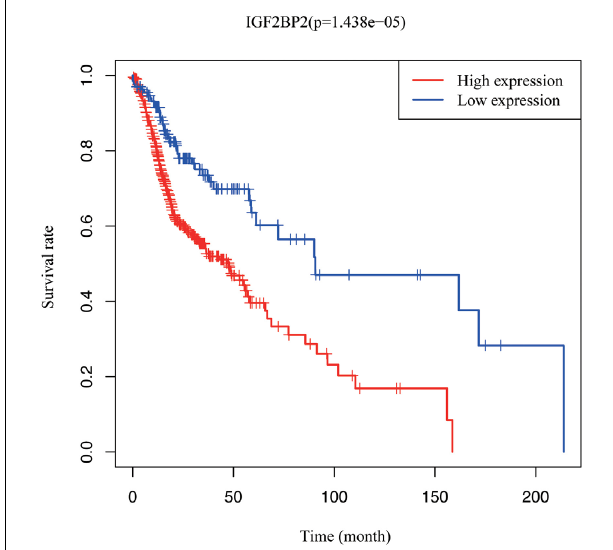
FIGURE 3 | Survival analysis of IGF2BP2 expression in terms of overall survival. Kaplan–Meier curves produced survival analysis.